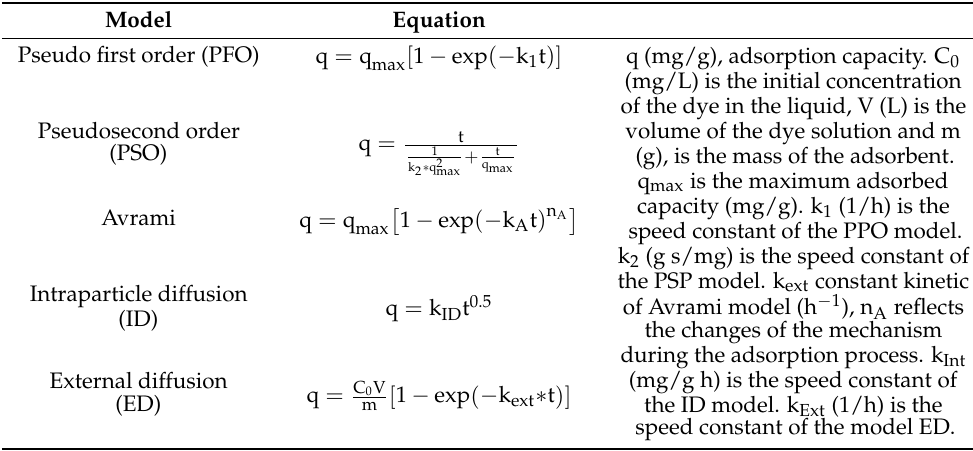
Table 5. Adsorption kinetic models used for the analysis of experimental data